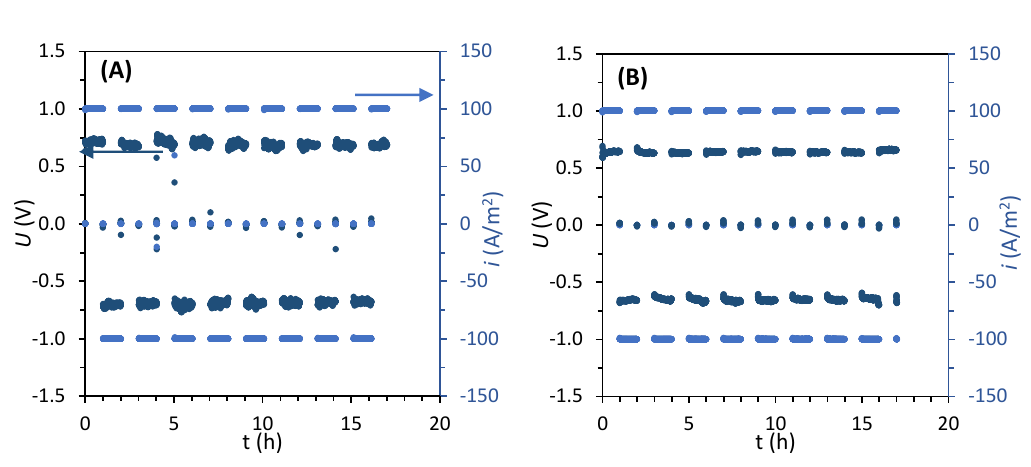
Figure 2. Electric potential U (marine) and current density i (light blue) versus time during the desalination of NaCl 0.5 M (stage I) in EDR mode. Values measured for the stack composed by ( A ) Neosepta AMX and ( B ) FujiFilm-10. The plots obtained from the other stacks can be found in the Supplementary Material. Table 4. Average absolute potential | ¯U | measured while desalting NaCl 0.5 M solution at 100 A / m 2 .